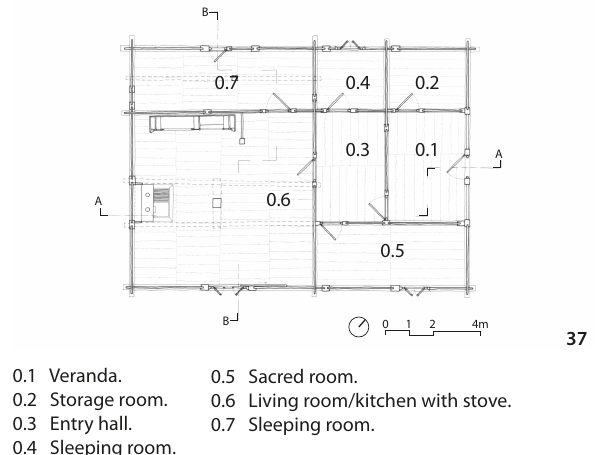
Figure 37 Ground floor plan of the farmhouse in Pome (Source: the